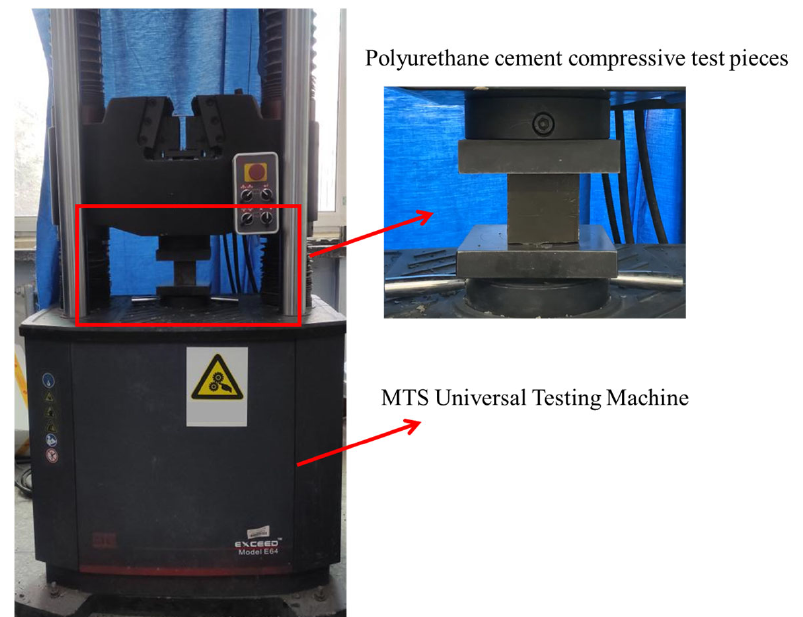
Figure 14. Polyurethane cement specimen pressure loading test.